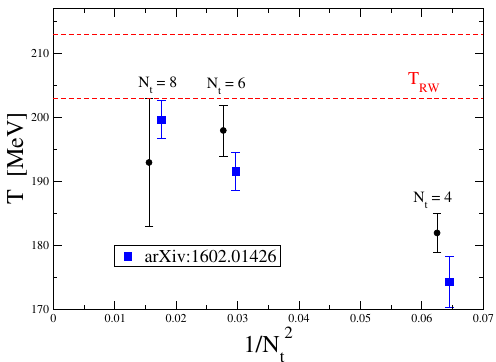
Figure 3. Left: I s ( s 0 (cid:10) 0 . 508) in QCD at ˆ μ I = π and T = 394 MeV for N 3 0 spatial size. The Poisson and RMT expectation and the critical value I crit temperature dependence of the mobility edge in units of m ud . Figures from Ref. [19].